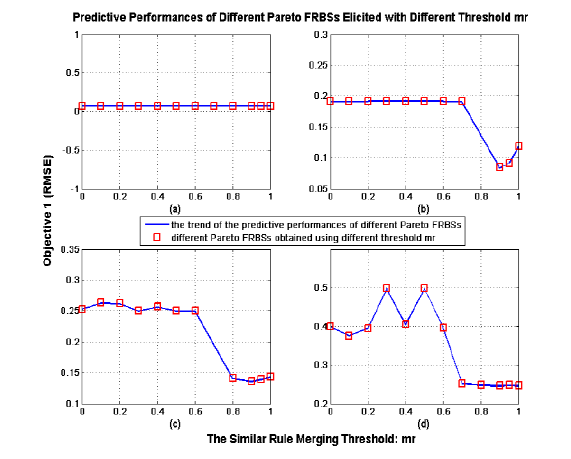
Fig. 14. (a) 5-rule FRBS; (b) 4-rule FRBS; (c) 3-rule FRBS; (d) 2-rule